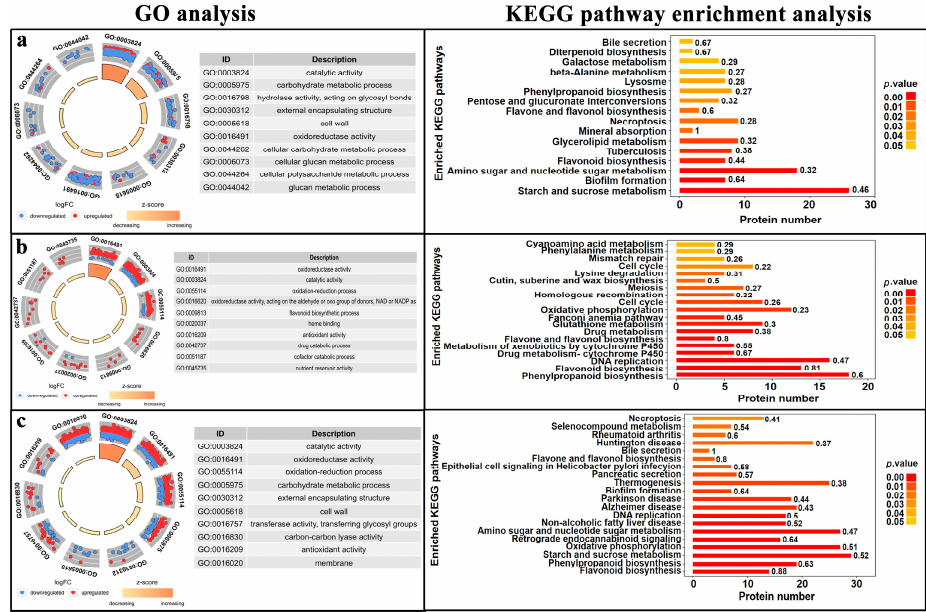
Figure 2. Results of the GO analysis and the KEGG pathway enrichment analysis of the ( a ) SEM vs. PEC, ( b ) CE vs. SEM, and ( c ) CE vs. PEC comparison groups.